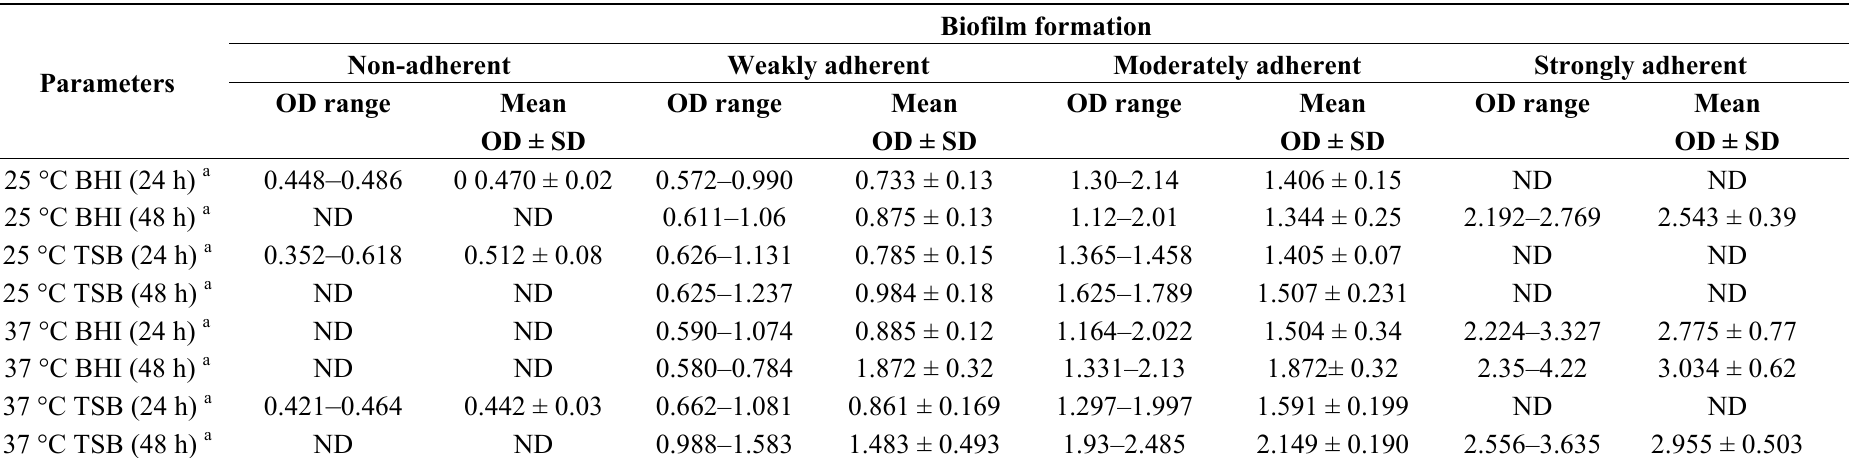
Table 2. The mean optical densities and standard deviations of the different biofilm